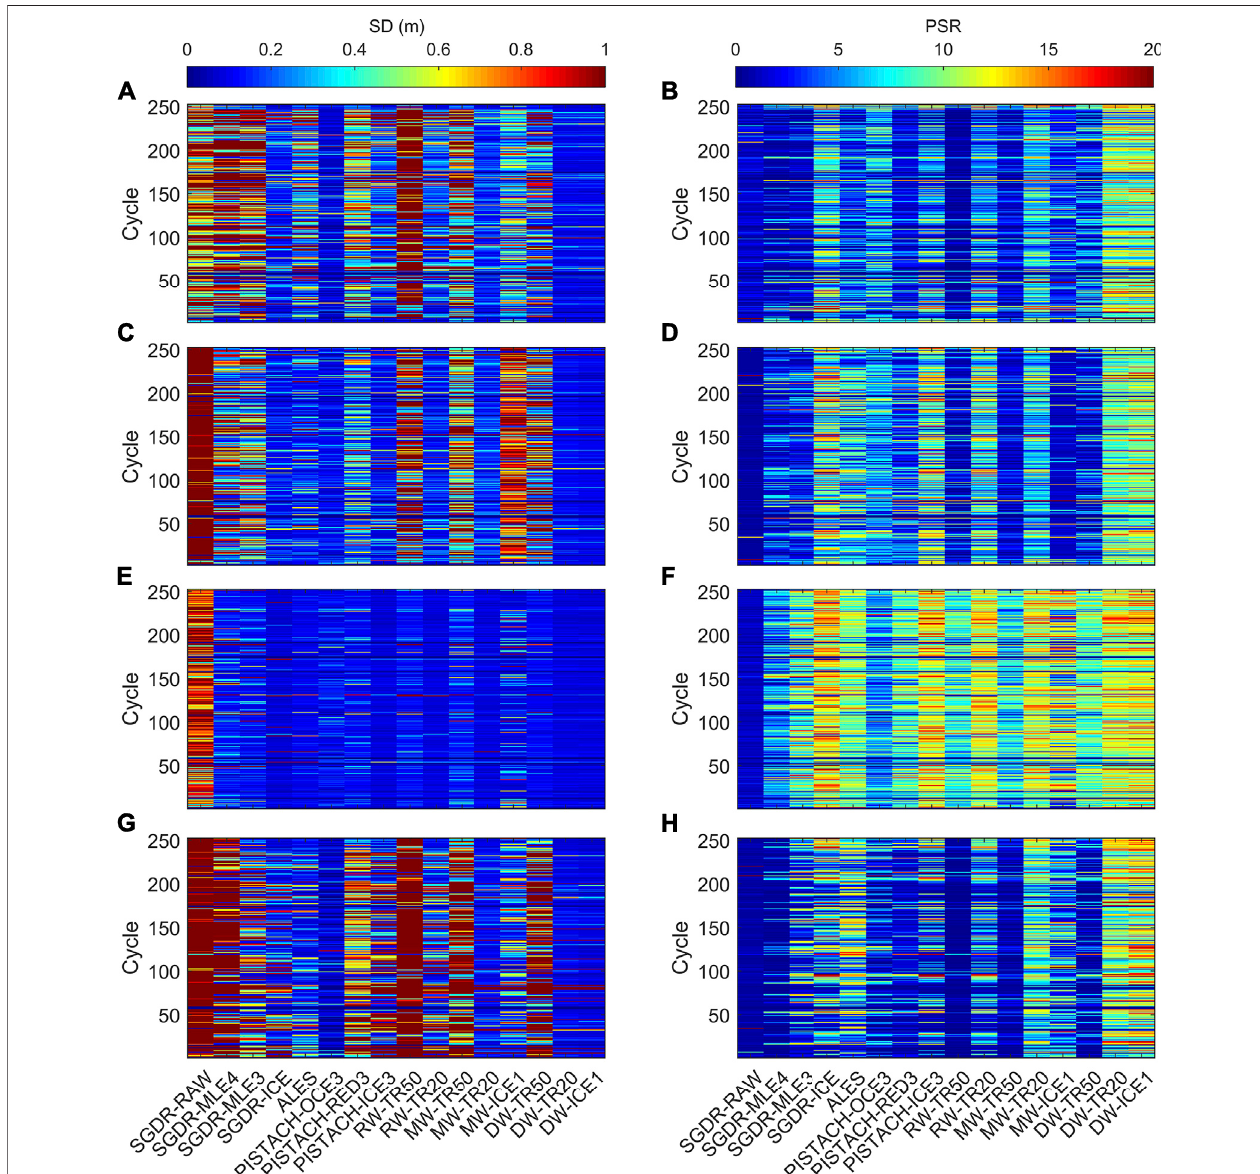
FIGURE 3 | Performance comparison of various retrackers in terms of SD (left) and PSR (right) in 0 – 10 km zone for each case: (A) – (B) Pass 119 near Los Angeles; (C) – (D) Pass 228 near Cape May; (E) – (F) Pass 61 near Funchal; (G) – (H) Pass 242 near Ko Lak.